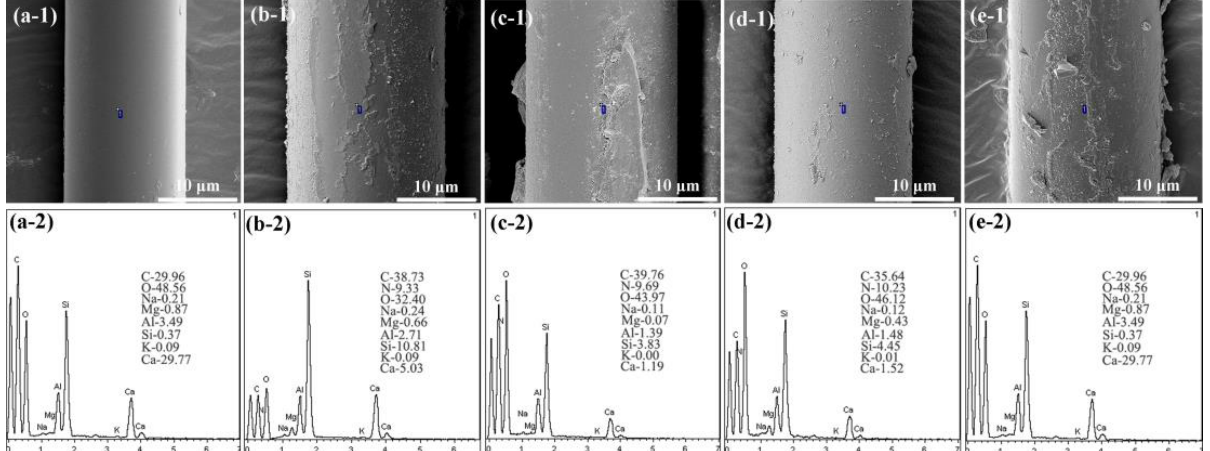
Figure 4. SEM morphology and EDS results of five types of waste glass fibers before and after treatment. ( a-1 ) SEM image of UWF; ( a-2 ) EDS image and the percentages of the elements present in the UWF; ( b-1 ) SEM image of MWF1; ( b-2 ) EDS image and the percentages of the elements present in the MWF1; ( c-1 ) SEM image of MWF2; ( c-2 )EDS image and the percentages of the elements present in the MWF2; ( d-1 ) SEM image of MWF3; ( d-2 ) EDS image and the percentages of the elements present in the MWF3; ( e-1 ) SEM image of MWF4; ( e-2 )EDS image and the percentages of the elements present in the MWF4.